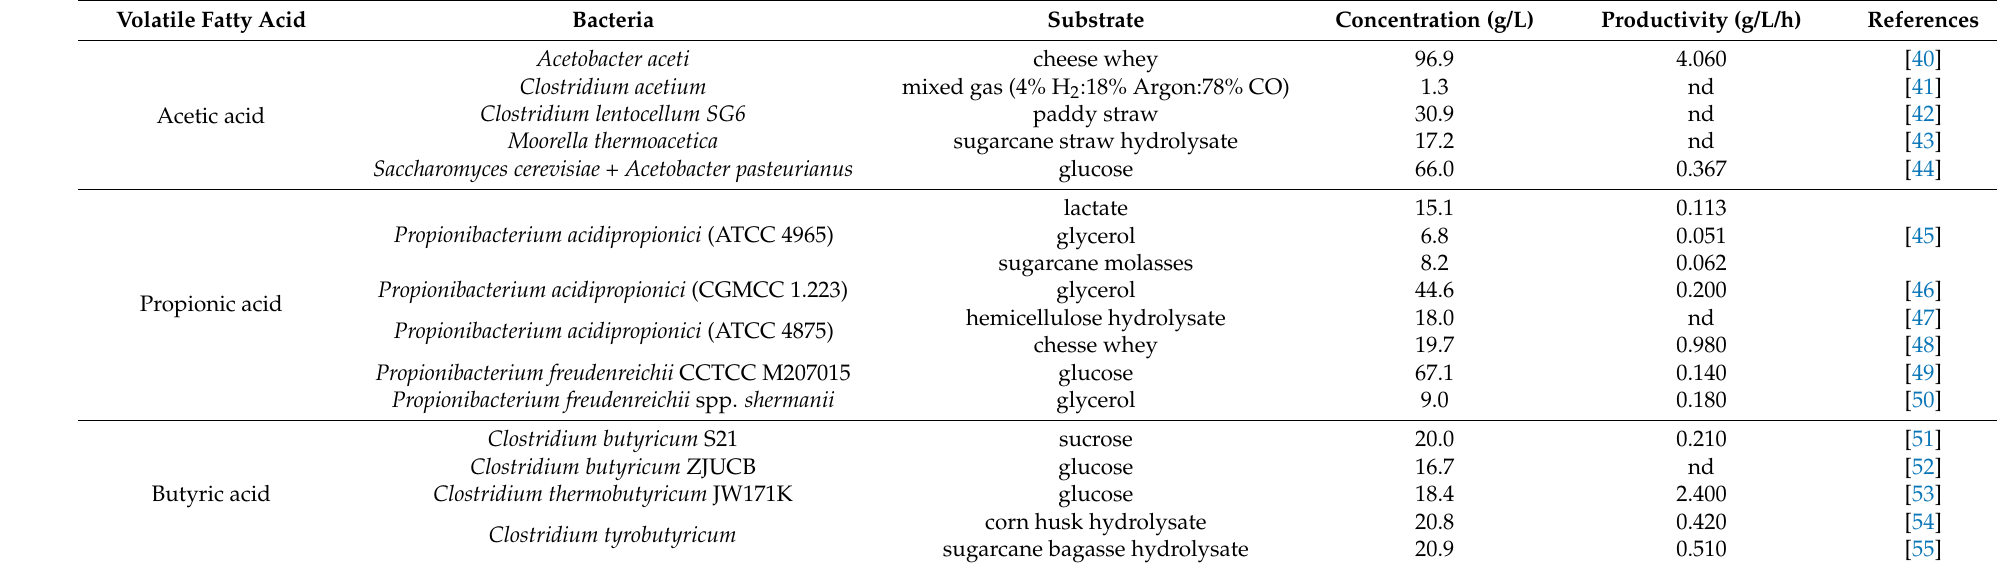
Table 2. Production of volatile fatty acids by